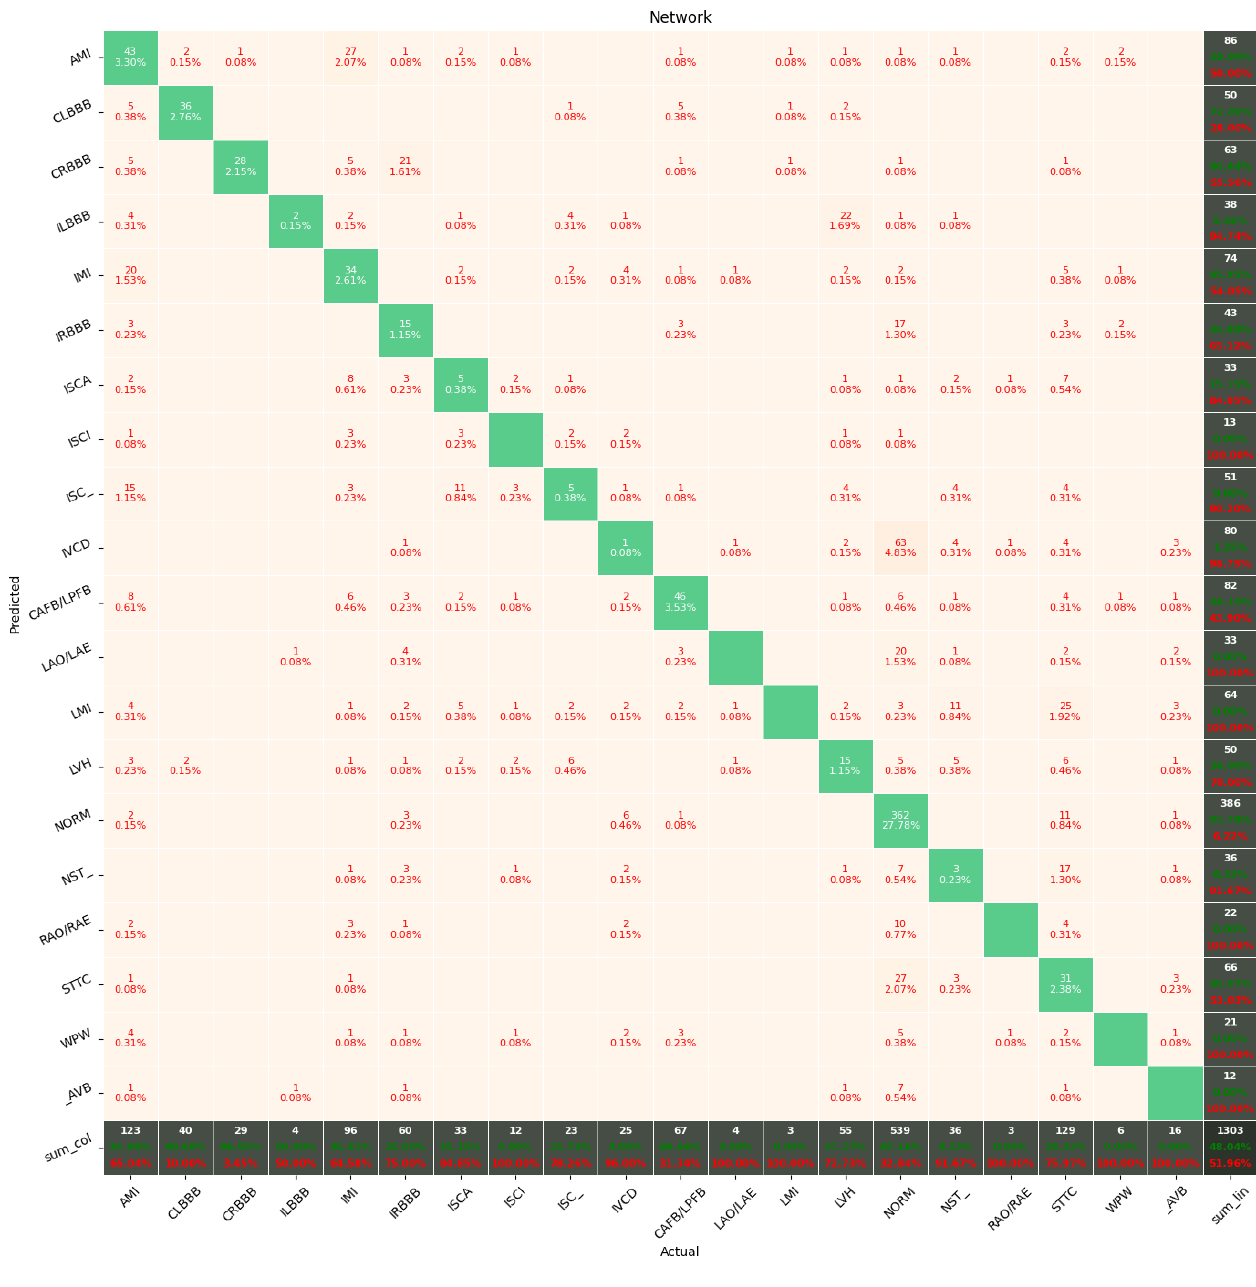
Figure 11. Confusion Matrix for Few-Shot (20 classes) with proximity-based